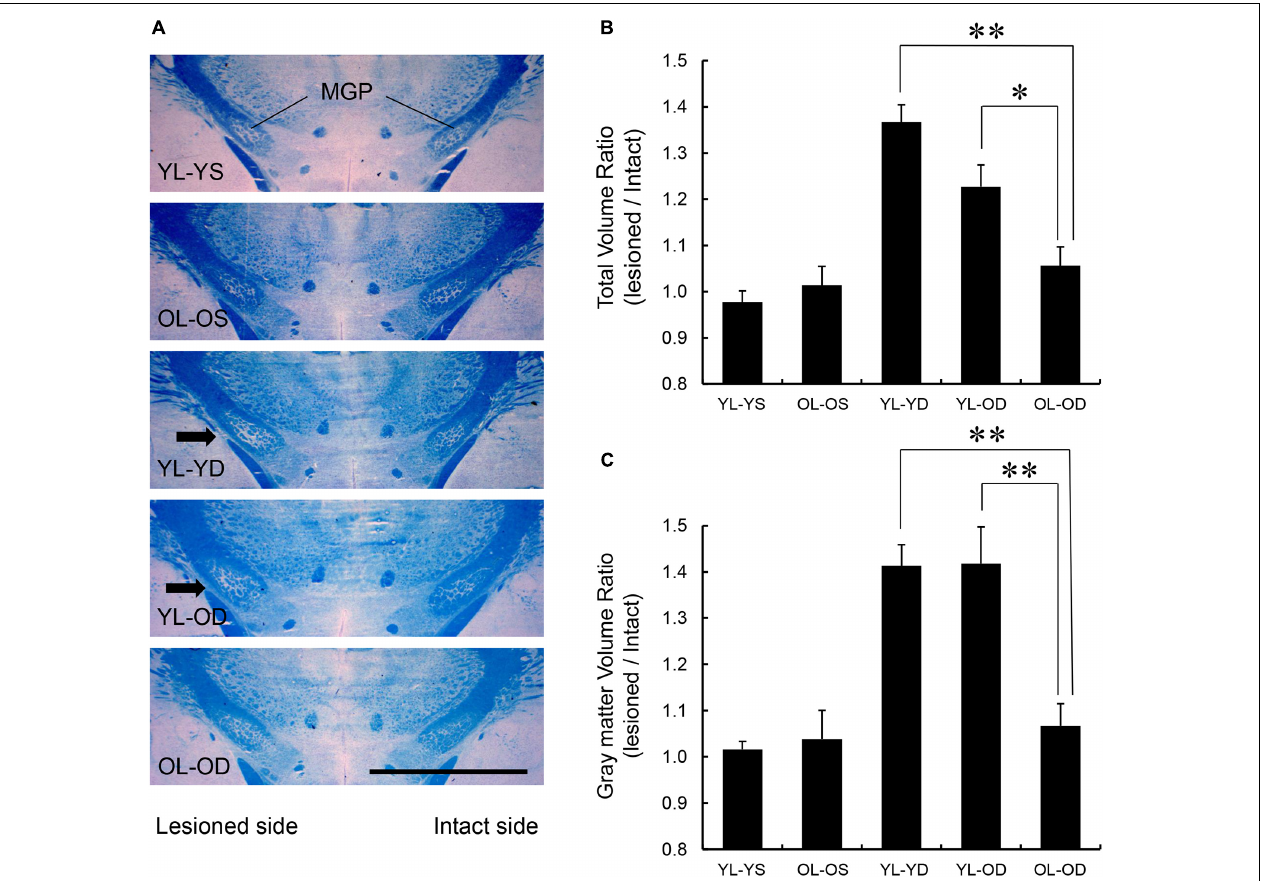
FIGURE 5 | MGP volume in the five experimental groups. (A) Coronal frozen sections through the MGP of rats in each treatment group. Arrows in the images of YL-YD and YL-OD groups indicate MGP hypertrophy on the lesioned side. Klüver-Barrera stain. Scale bar, 3 mm. (B) Total volume ratio of the MGP of YL-YD group was significantly higher than that in the OL-OD group. The YL-OD group also showed increased ratio compared with that of the OL-OD group. There was no significant difference between the YL-YD and YL-OD groups. There were significant differences for YL-YS versus YL-YD, YL-YS versus YL-OD, OL-OS versus YL-YD, and OL-OS versus YL-OD groups (not indicated in the figure). (C) The gray matter volume ratio of the MGP of the YL-YD group was significantly higher than that of the OL-OD group. The YL-OD group showed increased ratio compared with that in the OL-OD group. There was no significant difference between the YL-YD and YL-OD groups. There were significant differences for YL-YS versus YL-YD, YL-YS versus YL-OD, OL-OS versus YL-YD, and OL-OS versus YL-OD groups (not indicated in the figure). * p < 0.05; ** p < 0.01. Error bars represent standard error of the mean. L -dopa, levo-dihydroxyphenylalanine; MGP, medial globus pallidus; OL-OD, old-lesioned old- L -dopa group; OL-OS, old-lesioned old-saline group; YL-OD, young-lesioned old- L -dopa group; YL-YD, young-lesioned young- L -dopa group; YL-YS, young-lesioned young-saline